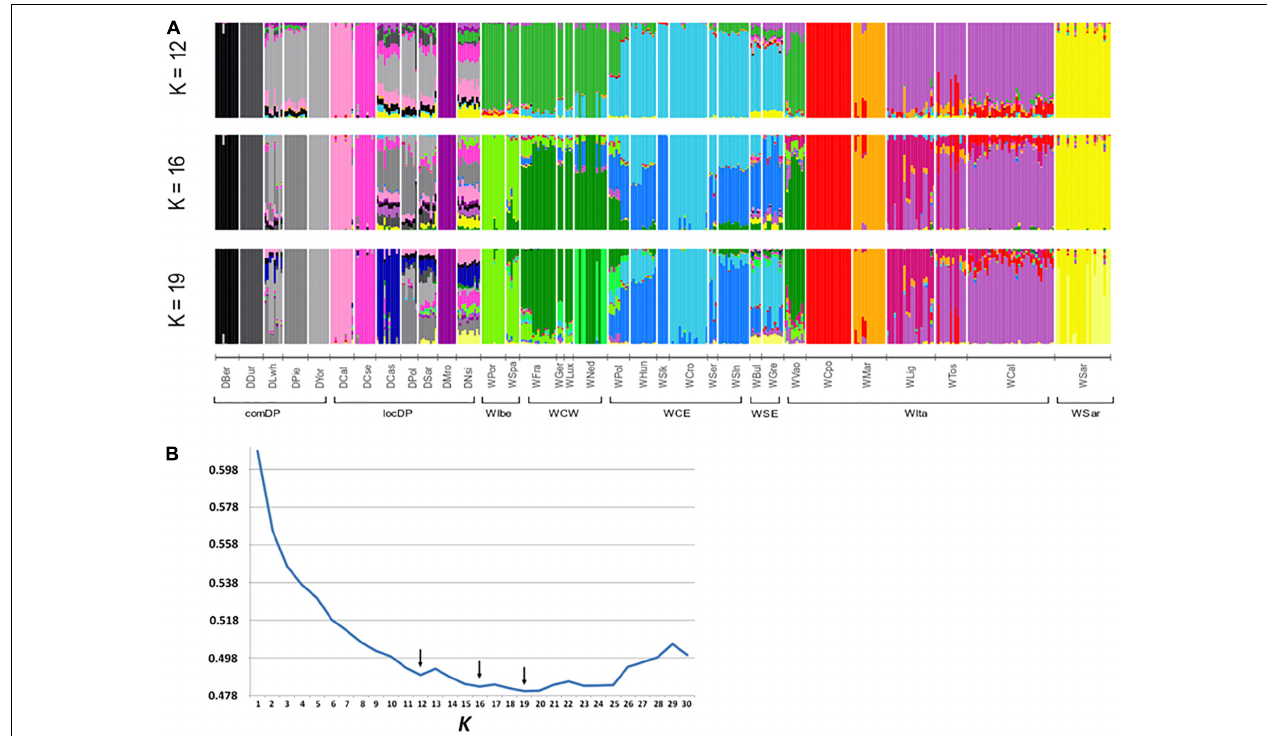
FIGURE 4 | Admixture analyses in wild boar (WB) populations conducted using the software ADMIXTURE. (A) Membership proportions of every genotyped individual to each of the K inferred clusters are shown as different colors. Reference European WB and domestic pig (DP) genotypes are included to test for genomic introgression in Italian WB. Histograms are reported for the best K values indicated by the cross-validation error (B) . Arrows in (B) indicate local minima. WB and DP population codes are shown in Table 1